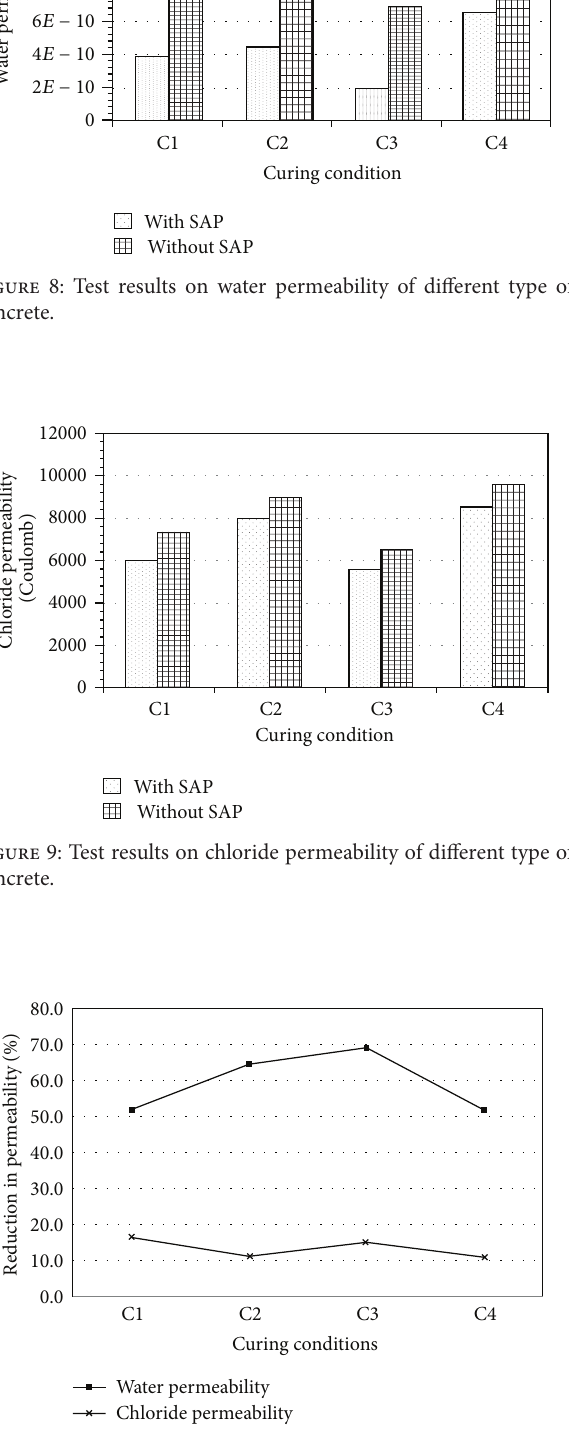
Figure 10: Reduction of water and chloride permeability in SP samples with respect to control samples under similar curing conditions.